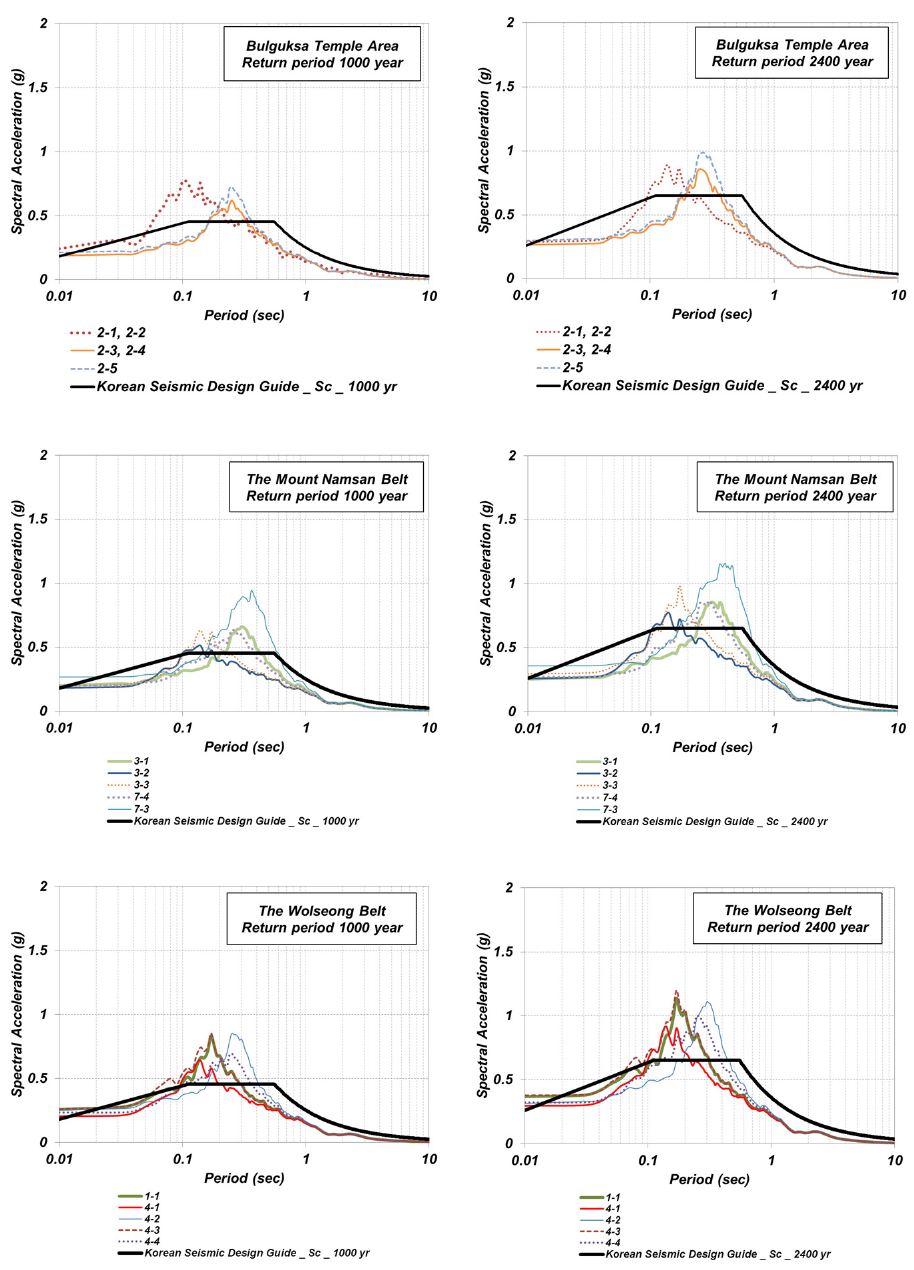
Fig. 5a. Comparison of response spectra between site-specific ground response analysis and Korean seismic design